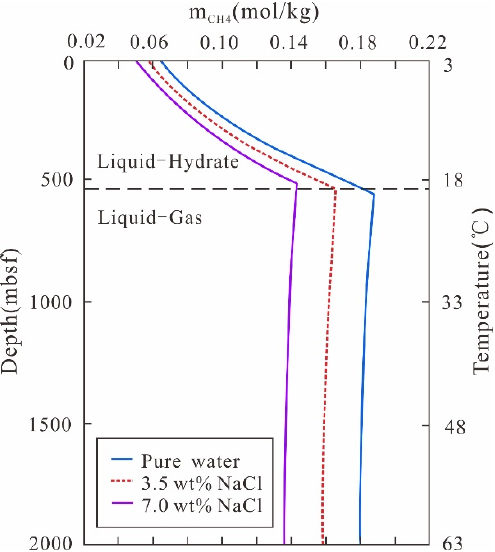
Figure 3. Trend of methane solubility in seawater with temperature and water depth (modified from Duan et al. [35] and Rui and Duan [83]).